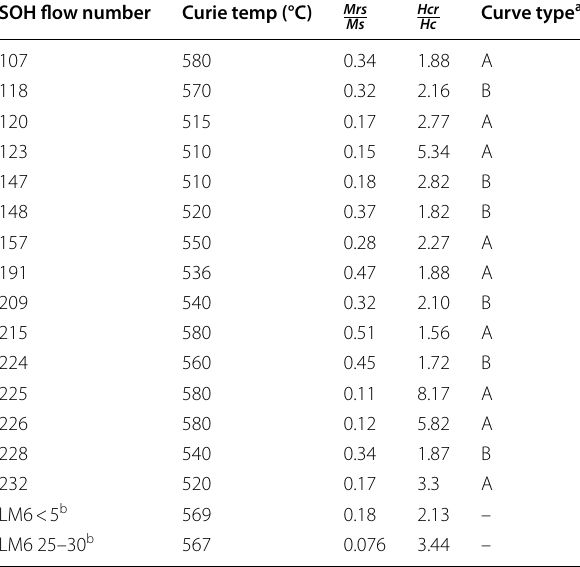
Table 2 Rock magnetic parameters for samples tested herein